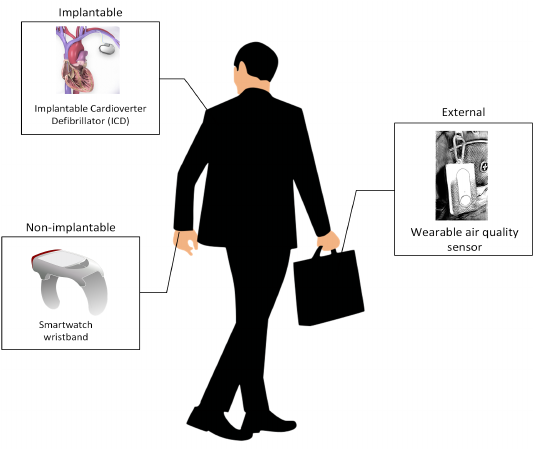
Figure 4. Wearable sensors based on intrusiveness